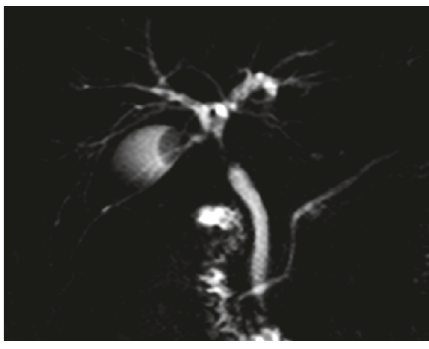
Figure 6: MRI cholangiography in a patient with Mirizzi type I mimicking a biliary